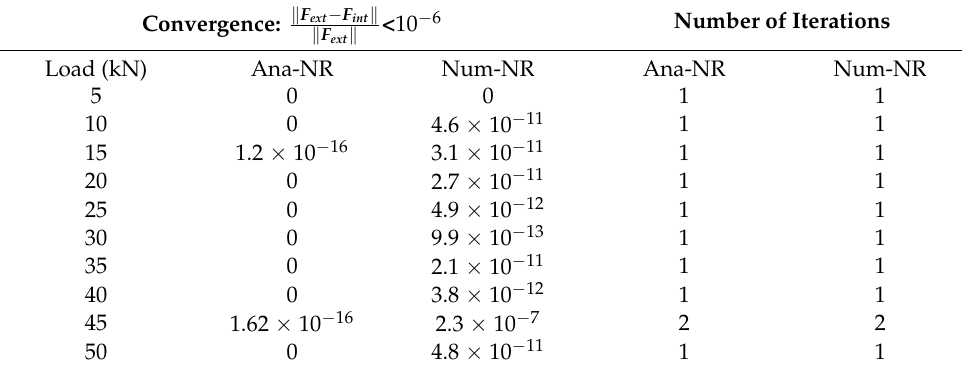
Table 1. Convergence rate and number of iterations by loading: 1D